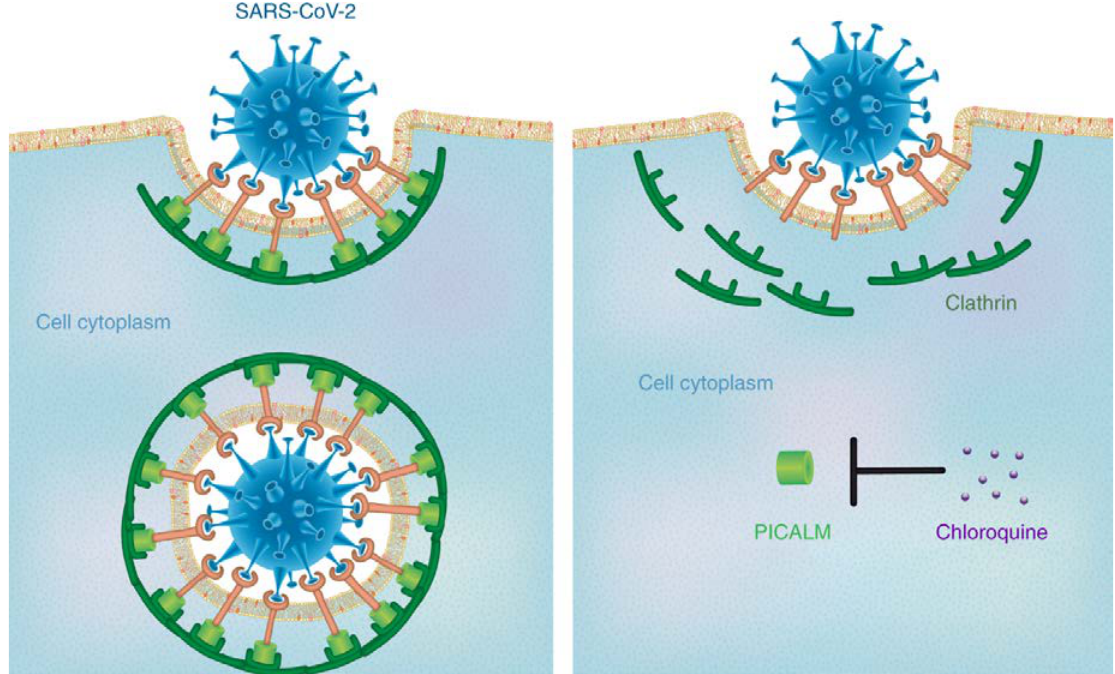
Figure 2. Mechanism of action of chloroquine against SARS-CoV-2. Reprinted with permission taken by Springer Nature [62].